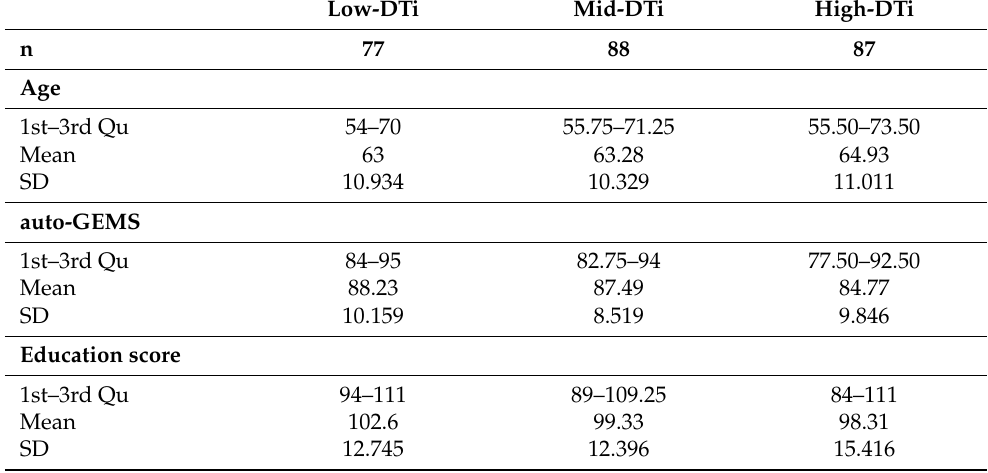
Table 7. Descriptive table for Age, auto-GEMS score, and Education score by cluster. The three different columns encompass participants with different levels of sensitivity to dual-task interfer- ence (DTi). The low-DTi cluster (left column) includes participants whose performance suffers less from dual-tasking. By contrast, the high-DTi cluster (right column) includes participants whose performance suffers more from dual-tasking.